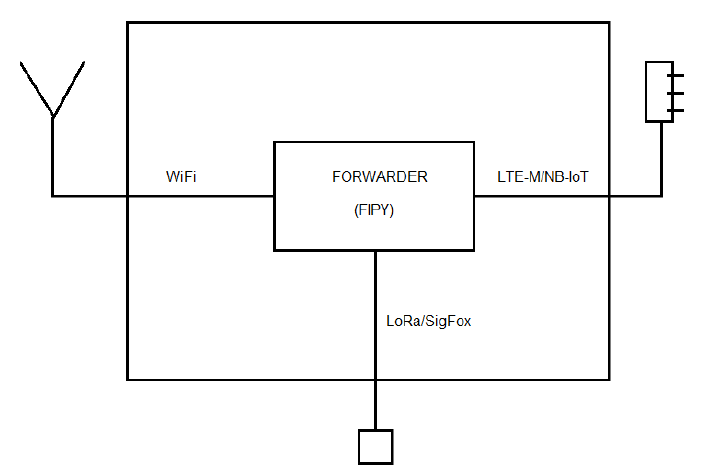
Figure 10. Prototyped Gateway.